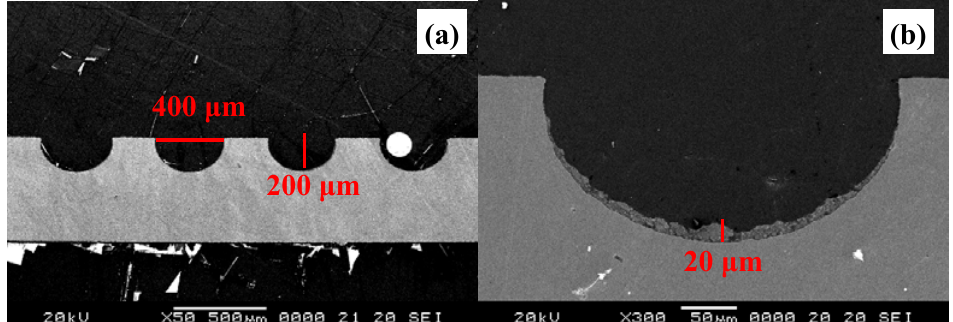
Figure 2. SEM microphotos of coating layers inside microchannels for (a) before washcoating (top view), (b) after washcoating (top view), (c) after washcoating (view of side cross-section) and (d) the fine porous structures of washcoat catalysts (portion of cross-section